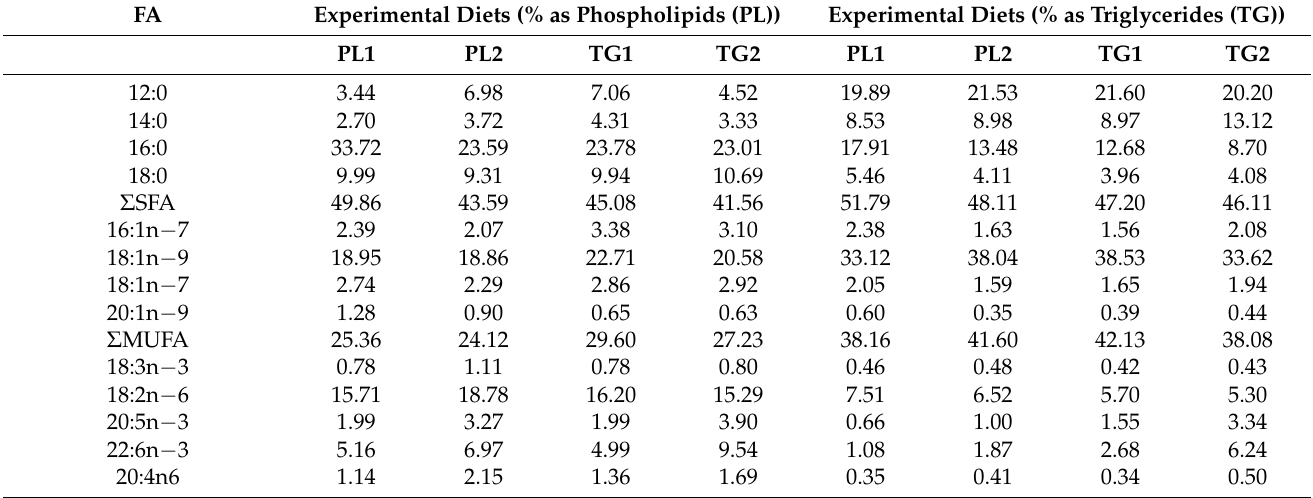
Table 2. Fatty acid profile of the neutral and polar fractions of the experimental diets (% of fatty acids). FA Experimental Diets (% as Phospholipids